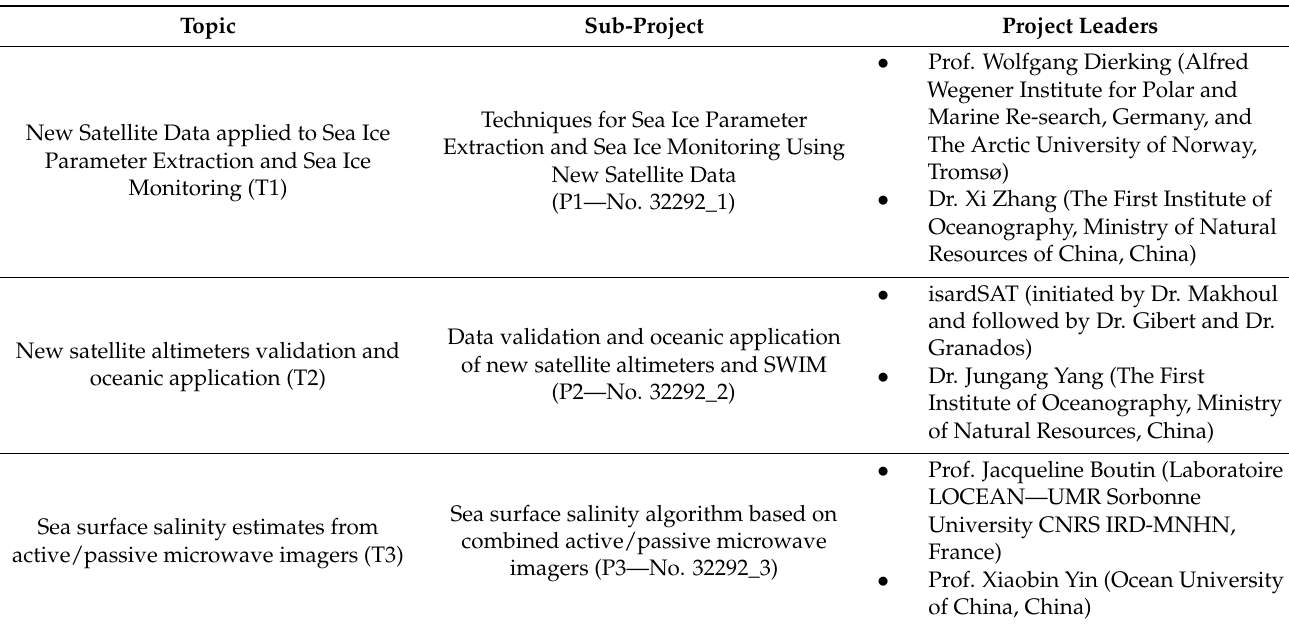
Table 1. Sub-projects and